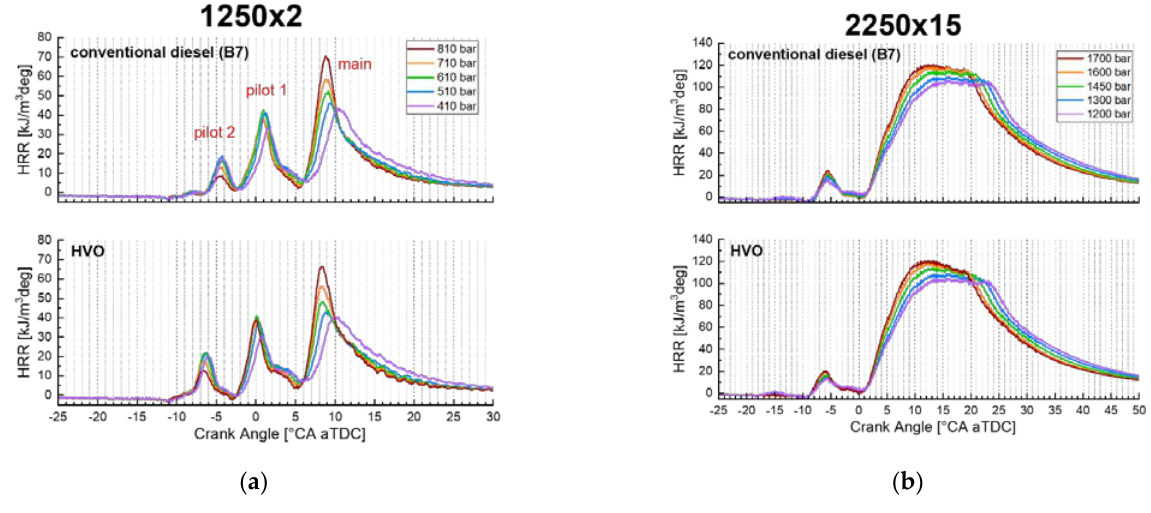
Rail pressure is a critical calibration parameter that influences the formation of air − fuel mixtures, which has a direct impact on pollutant emissions and engine performance. Figure 5 depicts the response of both investigated fuels to changes in fuel injection pressure (p rail ) in terms of HRR, at 1250 × 2 (cf. Figure 5a) and 2250 × 15 (cf. Figure 5b). Green solid lines represent tests performed with the baseline p rail values of the reference diesel-oriented calibration. For both fuels, orange and red lines indicate p rail higher than baseline, while blue and purple lines denote p rail lower than baseline.